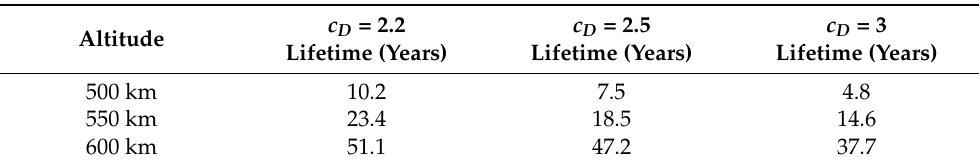
Table 3. CubeSat lifetimes, in years, modeled for different altitudes and drag coefficients ( c D ) using the Systems Tool Kit Satellite Lifetime tool.